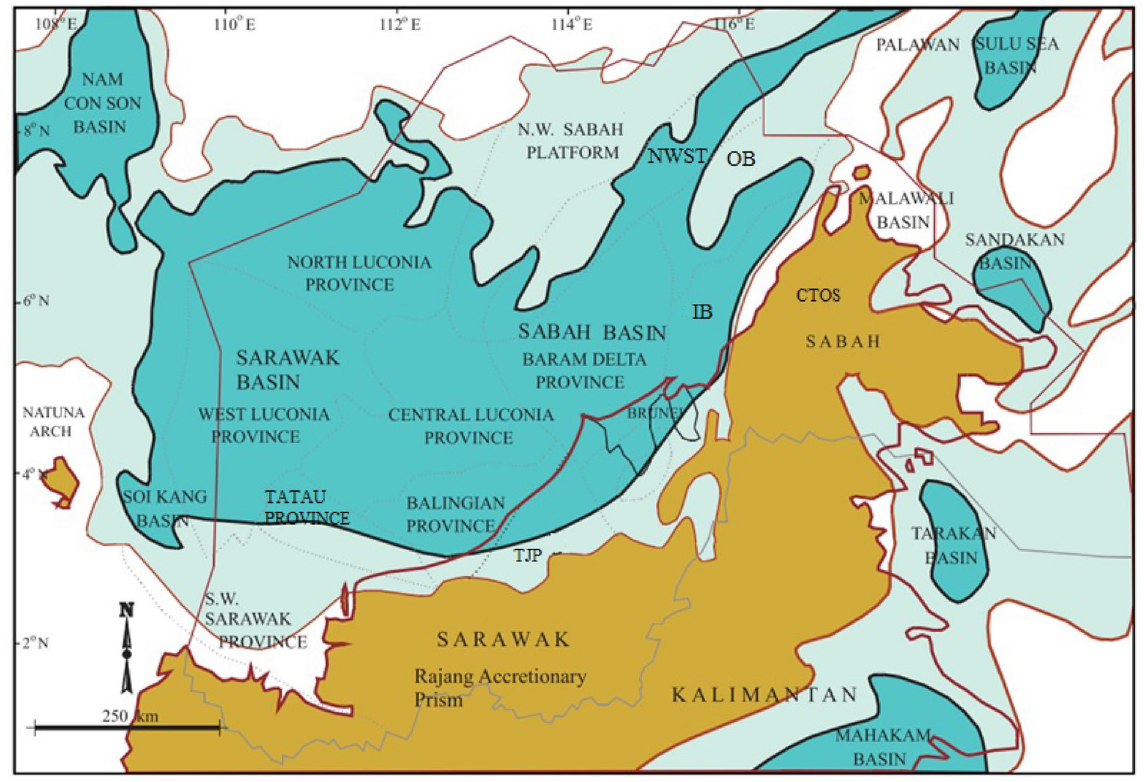
Fig. 2 Petroleum provinces of the Sarawak Basin and the contiguous NW Sabah Basin. NWST Northwest Sabah Trough, OB outboard belt, IB inboard belt, TJP Tinjar Province, CTOS Crocker-Trusmadi overthrust sheet (modified after Tjia